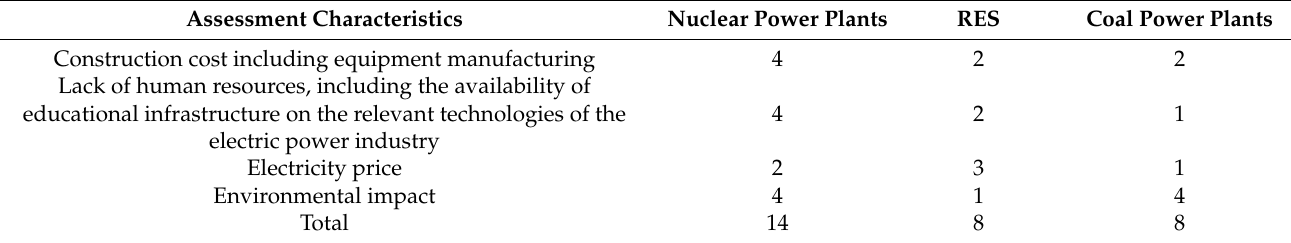
Table 2. Matrix for assessing the choice of using energy